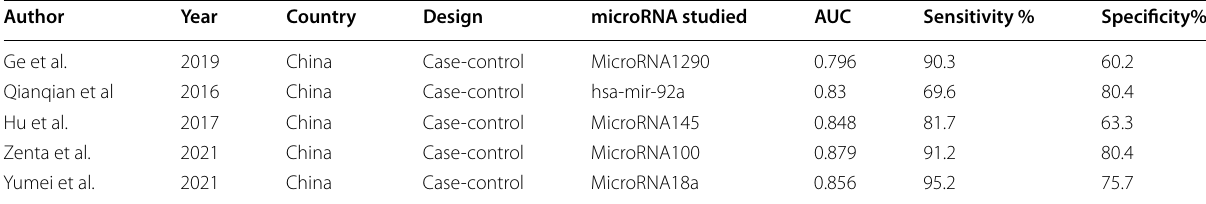
Table 3 Preliminary results of eligible studies